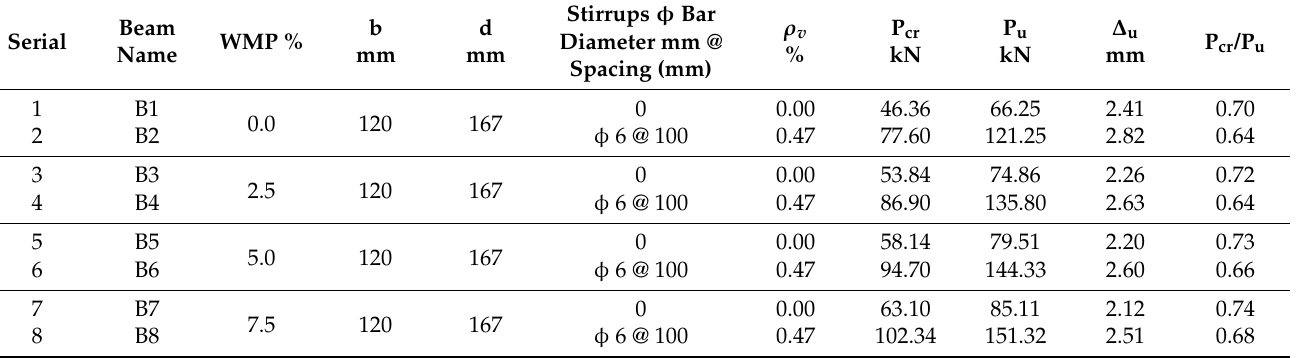
Table 7. Description of tested